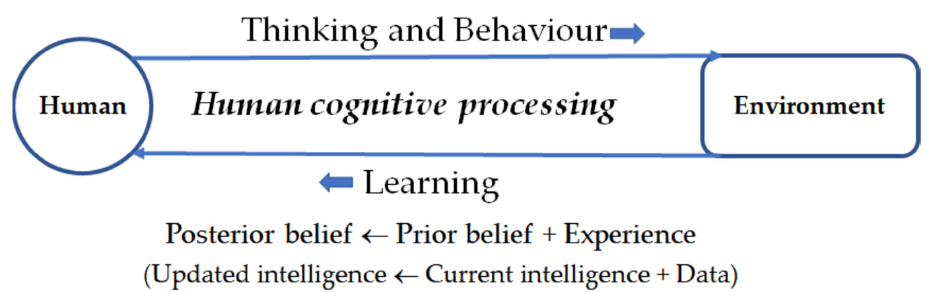
Figure 1. Human cognitive processing for thinking and behavior.